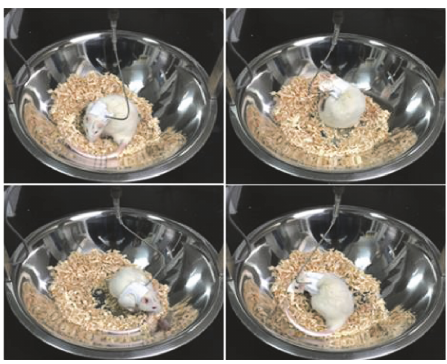
Figure 1: Apomorphine- (APO-) induced rotational behaviour in Parkinson ’ s disease (PD) model rats. The striatal dopamine receptors can be super-sensitized due to a marked decrease in striatal dopamine concentration by 6-OHDA injection. Therefore, apomorphine, which is a dopamine receptor agonist, injected into the peripheral tissues, can induce the rats to exhibit rotational behaviour to the